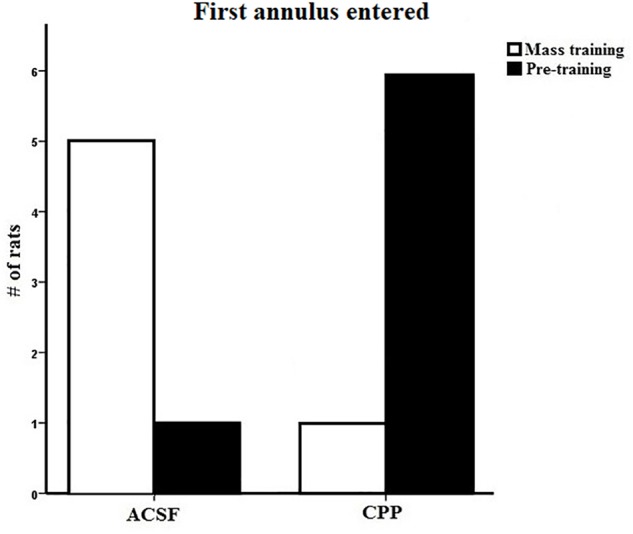
First annulus entered during the 24-h probe test for group 2 in Experiment 1. Five out of the six control rats first swam to the mass trained annulus where as six out of the seven CPP rats first swam to the pre-trained annulus.